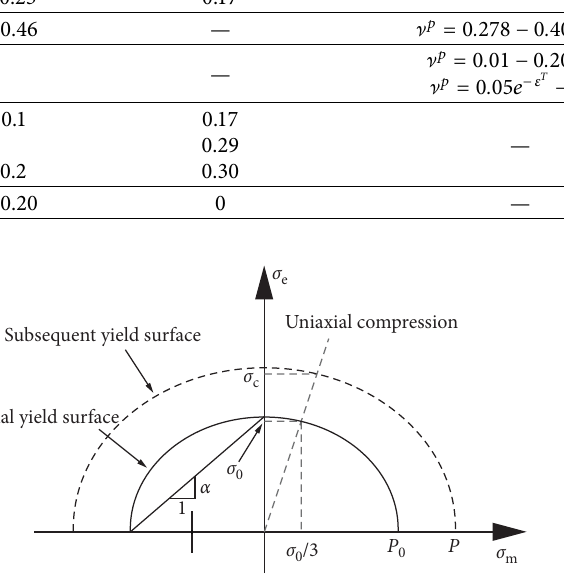
Figure 1: Yield surface for the Deshpande–Fleck foam stress tensor and the plastic strain rate tensor, respectively, where j � 1 , 2 , 3.